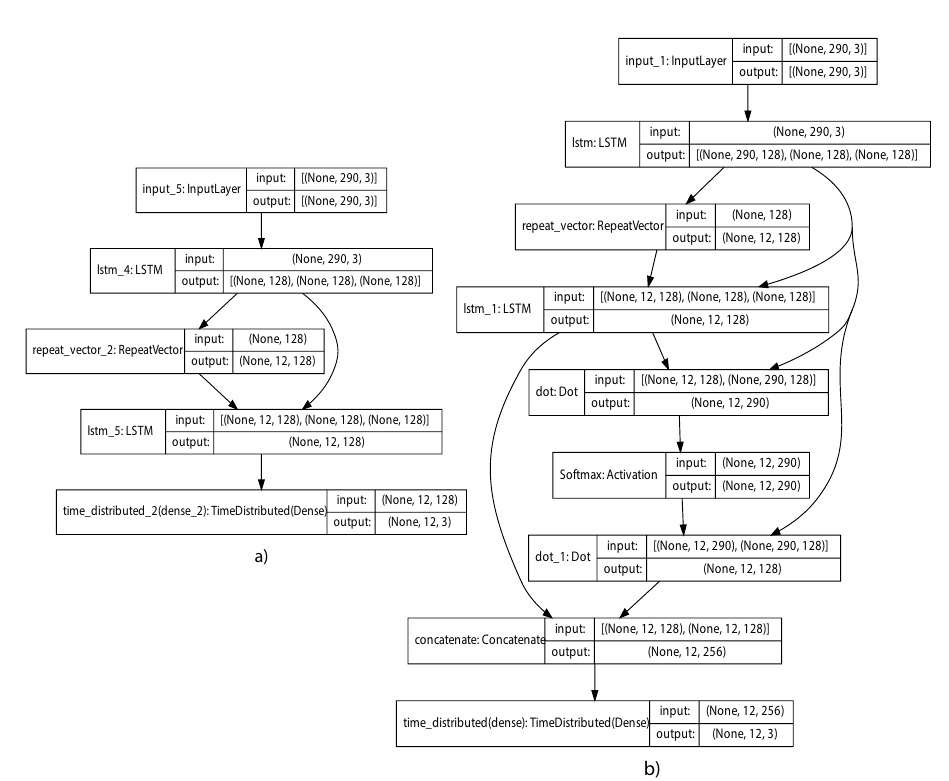
Figure 14. Flow Diagram of Seq2Seq Models. ( a ) Seq2Seq model flow diagram. ( b ) Attention model flow